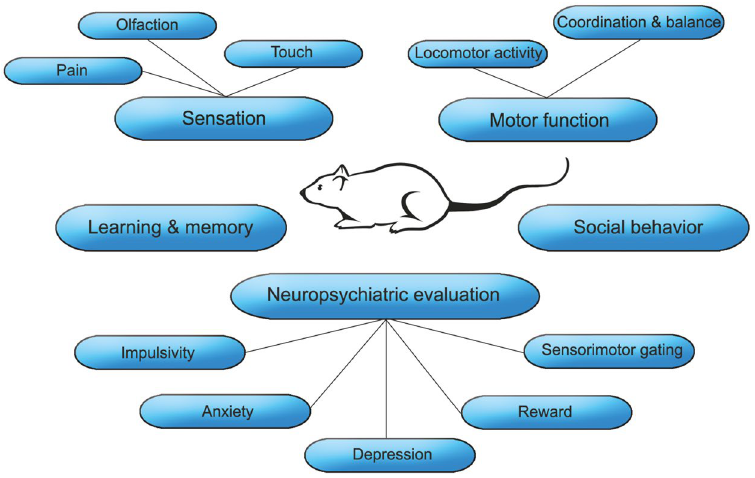
Figure 1. Schematic of behavioral tests used in this